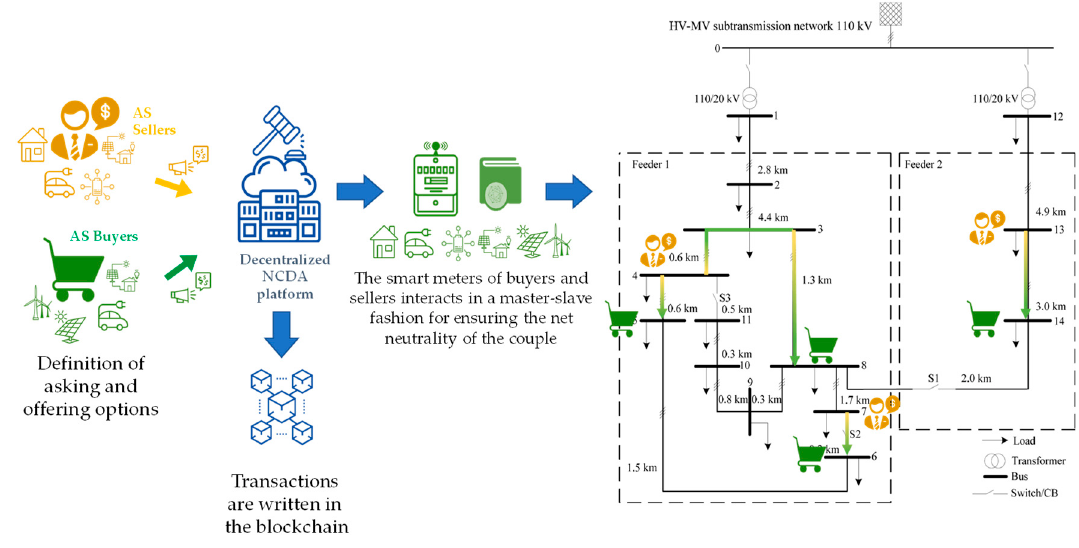
Figure 4. P2P decentralized AS market.